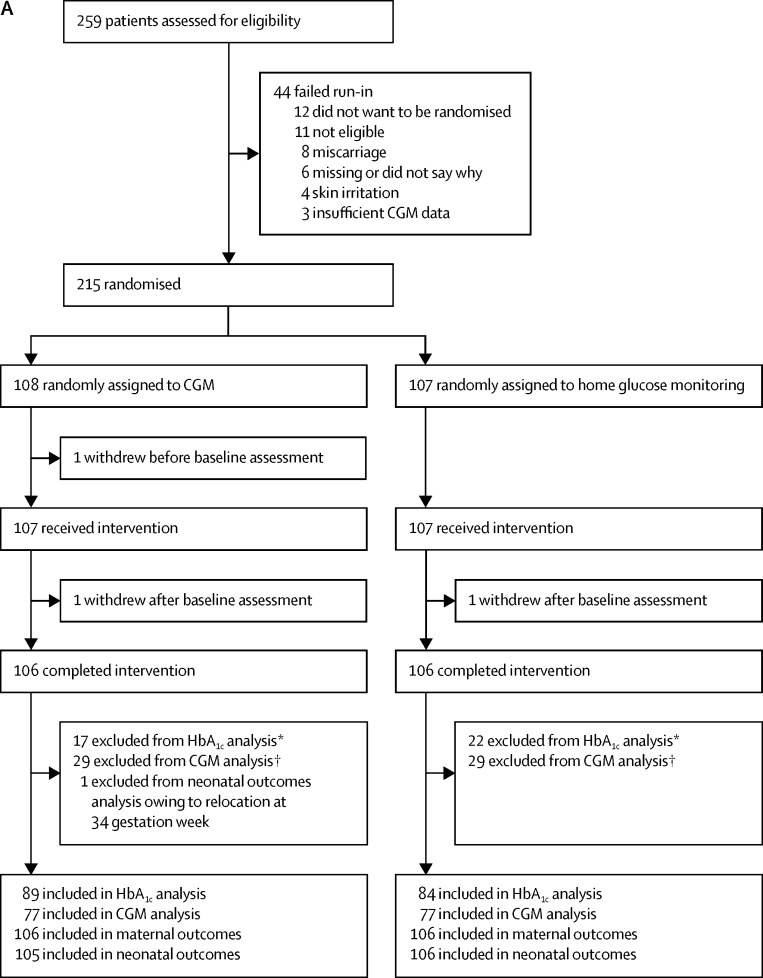
Trial profile for (A) participants in the pregnancy trial and (B) participants in the planning pregnancy trialCGM=continuous glucose monitoring. HbA1c= glycated haemoglobin. *Central laboratory HbA1c data were not available at randomisation for nine CGM group participants (six lost or not collected, two withdrawals, and one pregnancy loss) and 11 control group participants (nine lost or not collected, one withdrawal, and one pregnancy loss) and not available for an additional ten participants in the CGM group and 12 participants in the control group at 34 weeks. †CGM data unavailable. CGM data were available for 77 CGM participants using real-time sensor and 77 control group participants using an iPro2 masked sensor. ‡Central laboratory HbA1c measurements were not available for eight participants in the CGM group (five lost or not collected and three withdrawals) and six control group participants (five lost or not collected and one withdrawal). §CGM data not available. CGM data were available for 39 CGM participants using real-time sensor and 52 control group participants using an iPro2 masked sensor.